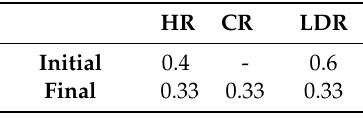
Table 2. Independent rates